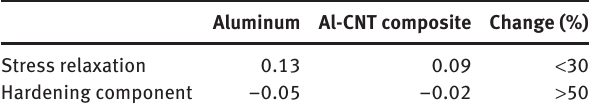
dominates the high-temperature deformation behavior of Table 3: Change in the rate of stress relaxation and hardening